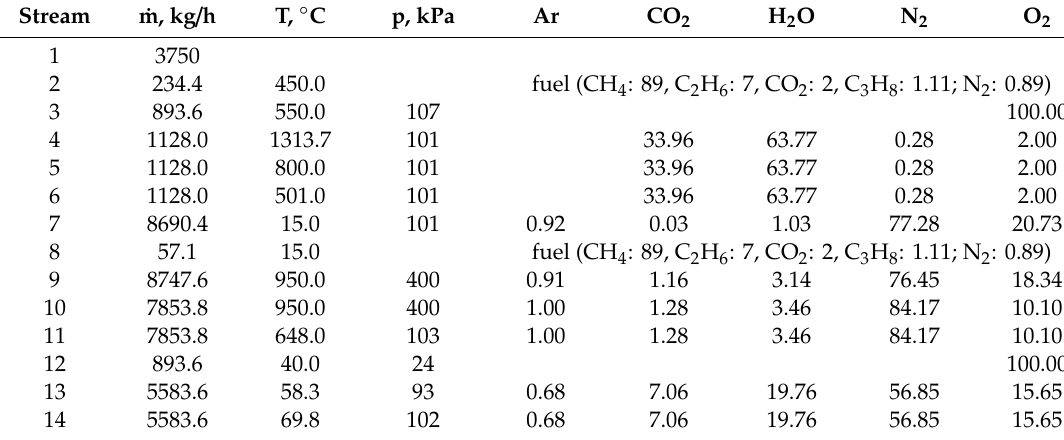
Table A3. Mass flow rates, temperatures, pressures and compositions (mol.%) at the main stations in Figure 13 for a glass melting furnace with production of 90 ton /